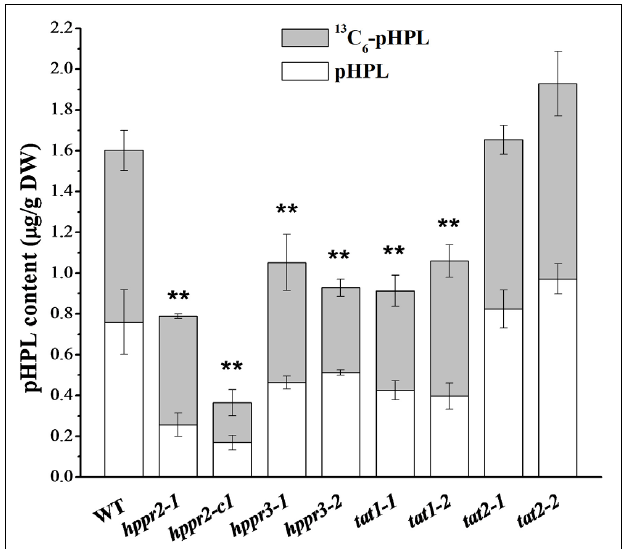
FIGURE 7 | HPPR and TAT are involved in pHPL biosynthesis from tyrosine. Quantification of 13 C 6 -pHPL and unlabeled pHPL in extracts of 14-day-old seedlings of WT, hppr2-1 , hppr2-c1 , hppr3-1 , hppr3-2 , tat1-1 , tat1-2 , tat2-1 , and tat2-2 fed with 250 µ M 13 C 6 -tyrosine for 24 h. Total pHPL contents